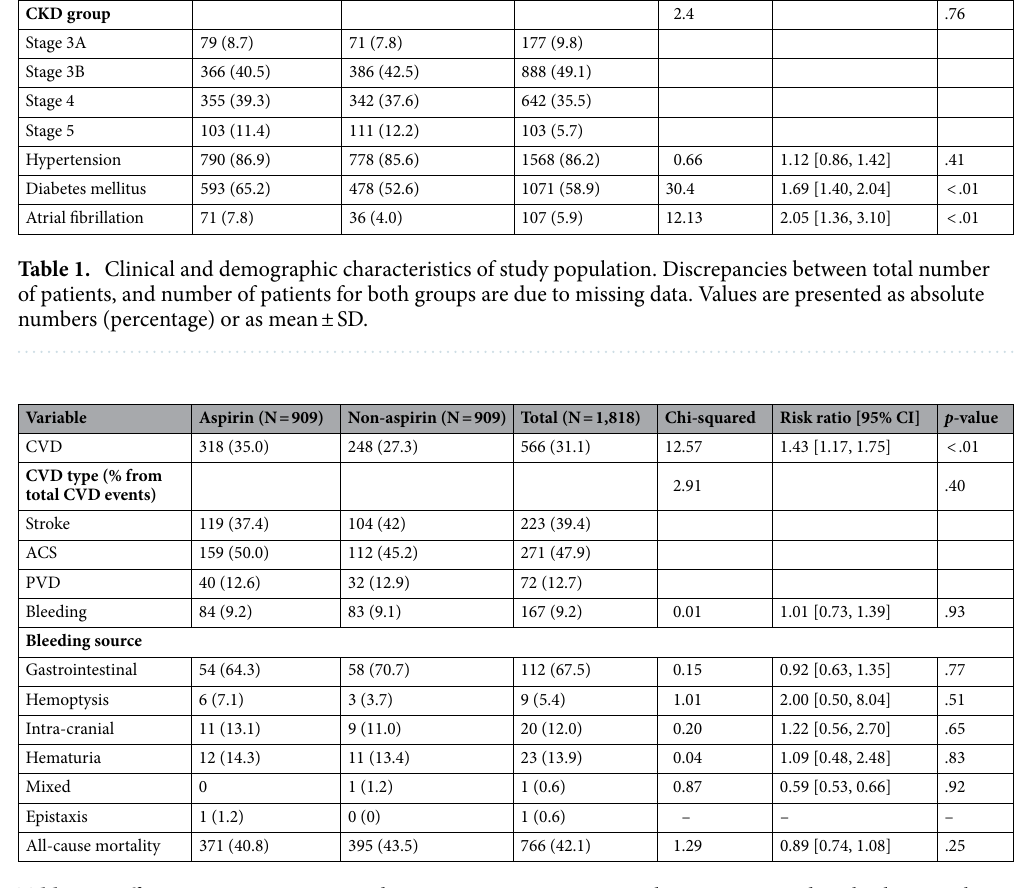
Table 2. Differences in outcomes according to aspirin prescription. Values are presented as absolute numbers (percentage). CVD cardiovascular disease; ACS acute coronary syndrome; PVD peripheral vascular disease.